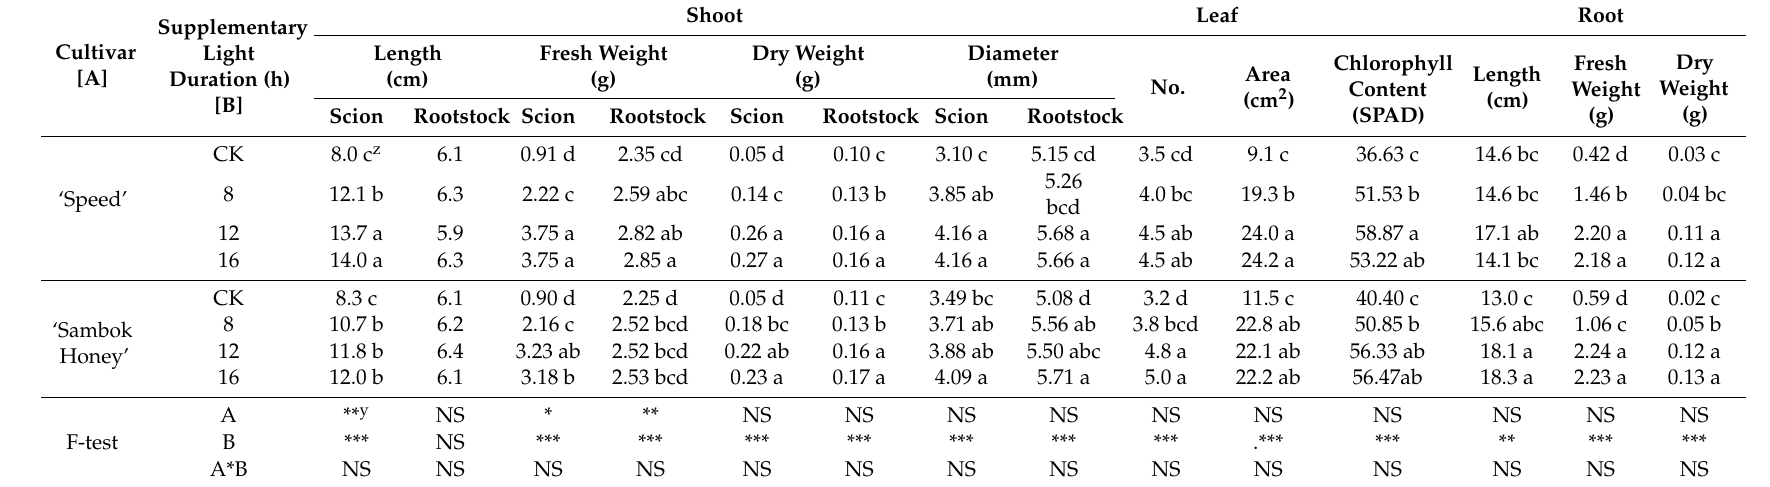
Table 1. The e ff ects of the supplementary light duration on the growth and development of two cultivars of watermelon ‘Speed’ and ‘Sambok Honey’ grafted onto ‘RS Dongjanggun’ bottle gourd rootstocks after 10 days of treatment.